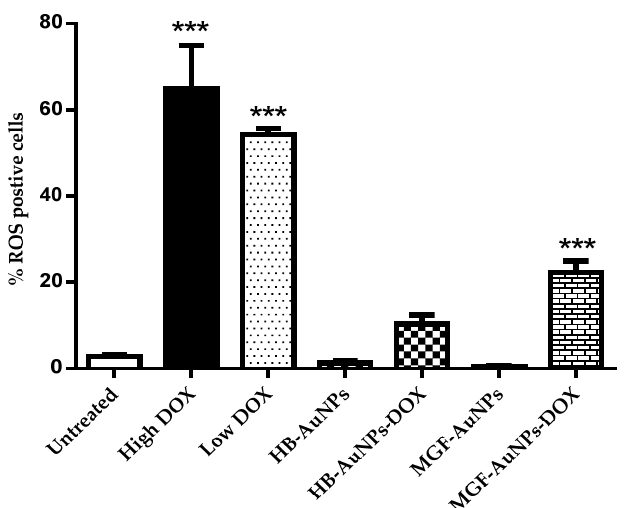
Figure 6. Effect of the treatments on ROS production. Caco-2 cells treated with Low DOX (1.56 µ g/mL), High DOX, MGF-AuNPs (1000 µ g/mL), HB-AuNPs (1000 µ g/mL), MGF-AuNPs-DOX (1000 µ g/mL MGF-AuNPs and 1.56 µ g/mL DOX) and HB-AuNPs-DOX (1000 µ g/mL HB-AuNPs and 1.56 µ g/mL DOX) and the level of ROS production was assessed using the CM-H2DCFDA probe and flow cytometry. Results are expressed as mean ± standard error of the mean (SEM). Data were considered statistically significant if p < 0.05, *** p < 0.001.